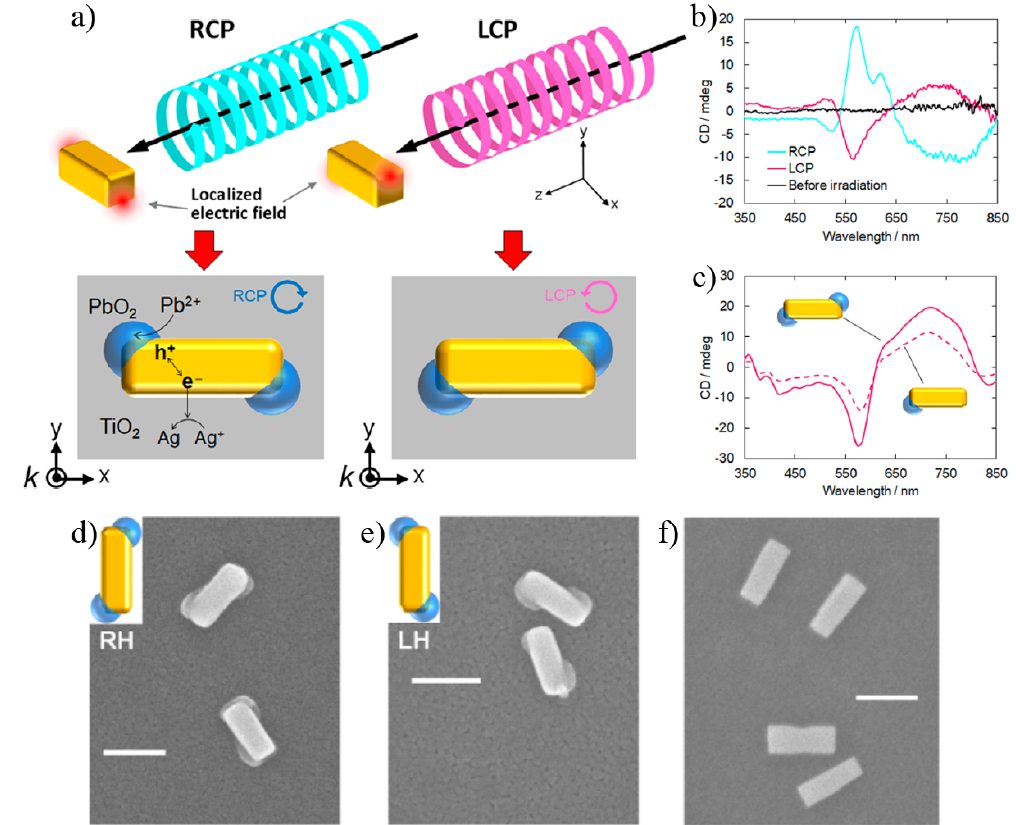
Figure 7. ( a ) Illustration of the deposition of a dielectric material (PbO 2 ) via Pb 2 + oxidation under CPL stimulus. ( b ) Substrate CD before the dielectric material deposition (black line) and after deposition under RCP (blue line) and LCP (red line) lights. ( c ) Comparison of CD spectra of a